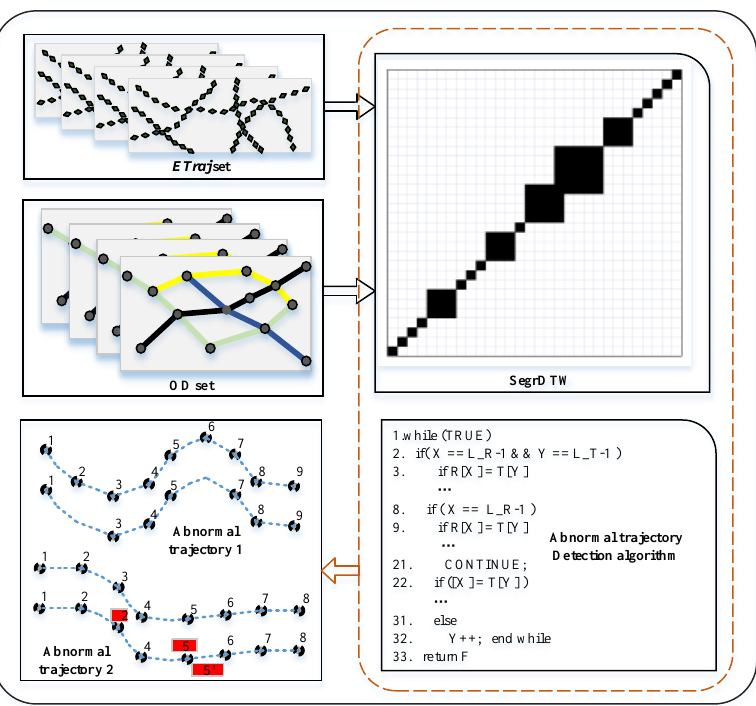
Figure 3. The framework diagram of the abnormal ETC transaction data detection algorithm.